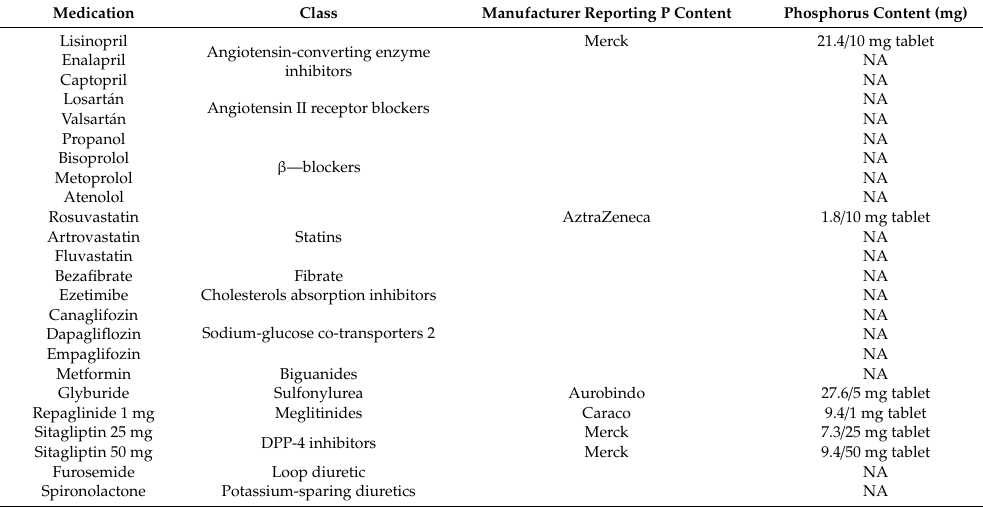
Table 3. Most common medications used in chronic kidney disease (CKD) patients and phosphorus content